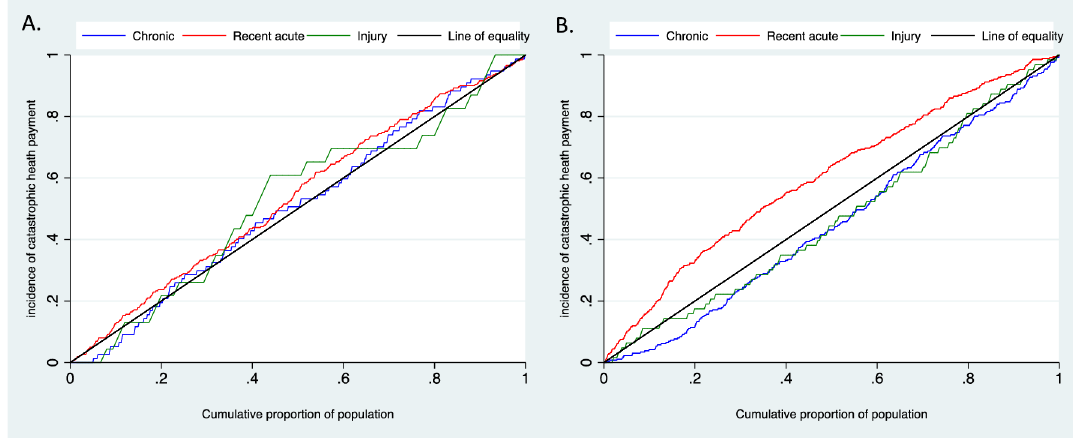
Fig 1. Concentration curve of catastrophic health payment by illness or symptom categories in Nepal. (A) in 1995 (B) in 2010.